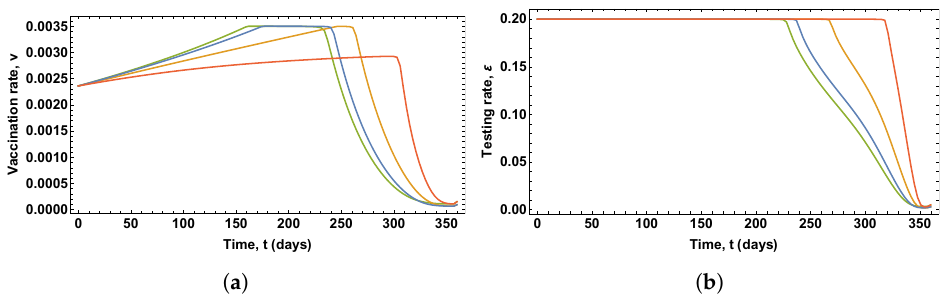
Figure 14. Optimal policies obtained assuming immunity loss rates ι = 0.0056 (red), ι = 0.0028 (orange), ι = 0.0014 (blue), and ι = 0.0009 (green), with C 1 = 1, C 2 = 0.1, and C 3 = 0.0001: ( a ) Optimal vaccination rates. ( b ) Optimal testing rates.